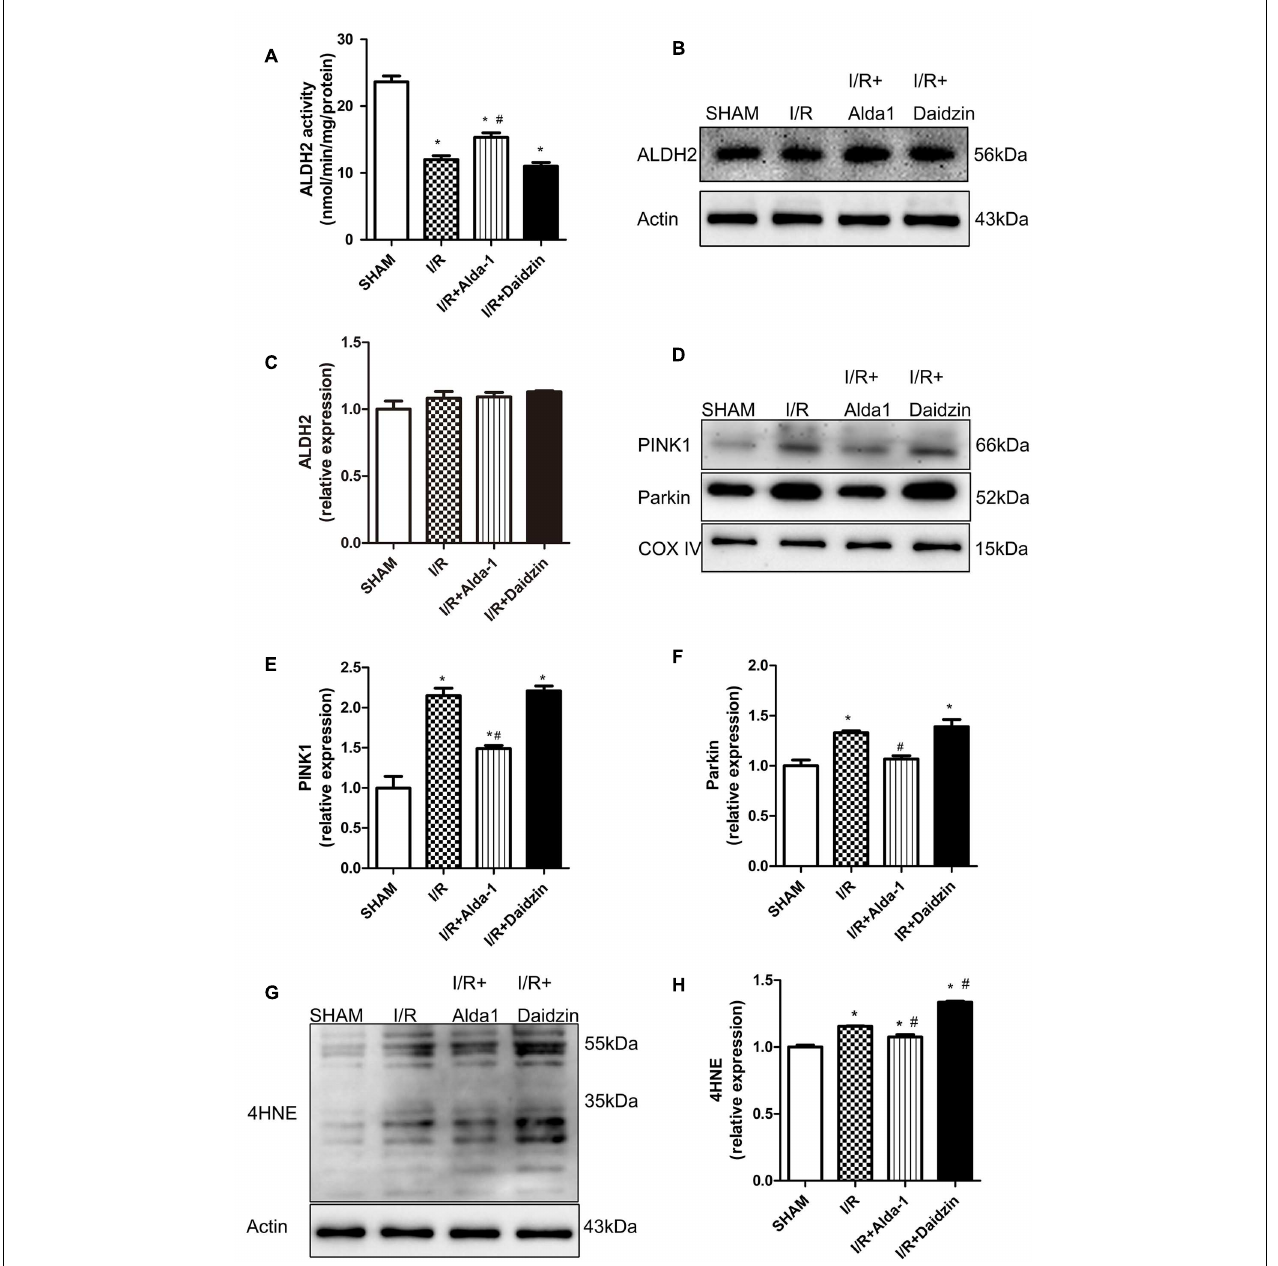
FIGURE 2 | ALDH2 activity and expression, 4HNE accumulation and mitophagy in I/R rats. (A) ALDH2 enzymatic activity ( P < 0.0001, One-way ANOVA). (B) Representative gel blots of expression of ALDH2 and Actin (loading control). Quantification analysis of (C) ALDH2 expression using specific antibodies ( P = 0.2671, One-way ANOVA). (D) Representative gel blots of expression of PINK1, Parkin and COX IV (mitochondrial loading control). Quantification analysis of (E) PINK1 expression and (F) Parkin expression ( P < 0.0001, P = 0.0012, One-way ANOVA). (G) Representative gel blots of expression of 4HNE. Quantification analysis of (H) 4HNE expression ( P < 0.0001, One-way ANOVA). n = 3/group. Data are mean ± SD from 3 independent experiments. ∗ P < 0.05 vs. sham; # P < 0.05 vs. I/R.